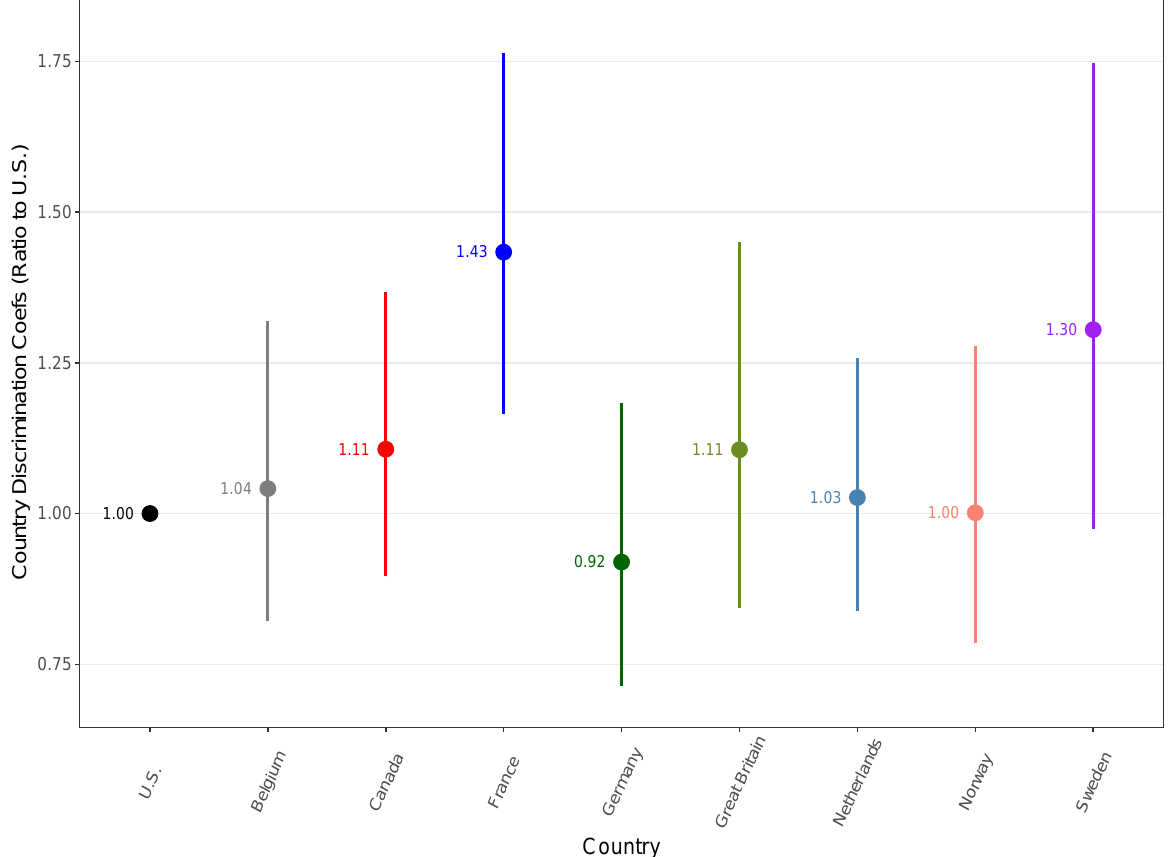
Figure 2: Country Discrimination Levels Relative to U.S.